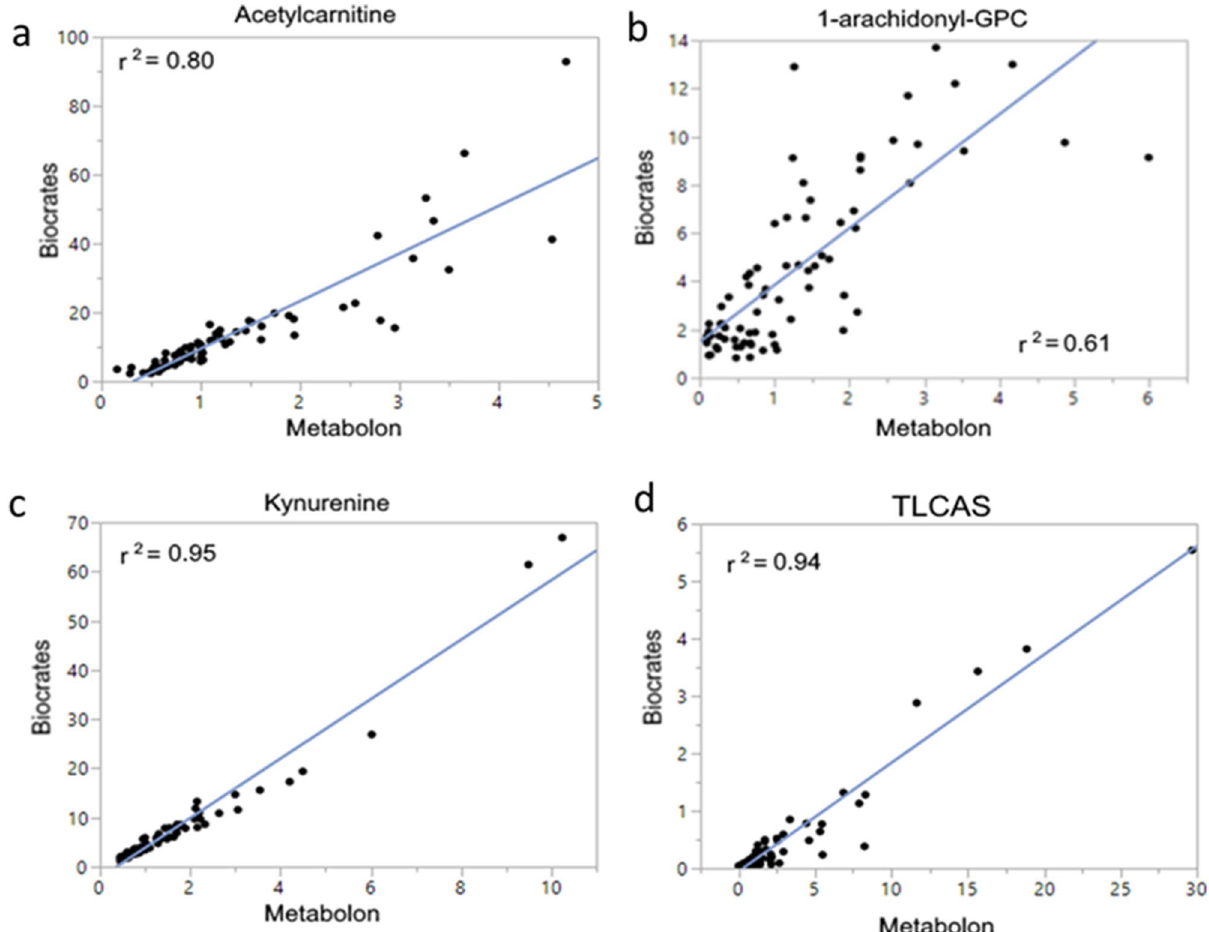
Figure 4. Correlation analysis of quantitative and semiquantitative results. Spearman’s Rank correlation analysis performed on quantitative (Biocrates) and semiquantitative (Metabolon) results shows a strong correlation (r = 0.79–0.97) and comparable predictive value for each pathway measured. Figures made utilizing JMP Genomics 8.0, https:// www. jmp. com/ en_ us/ softw are/ genom ics- data- analy sis- softw are. html.